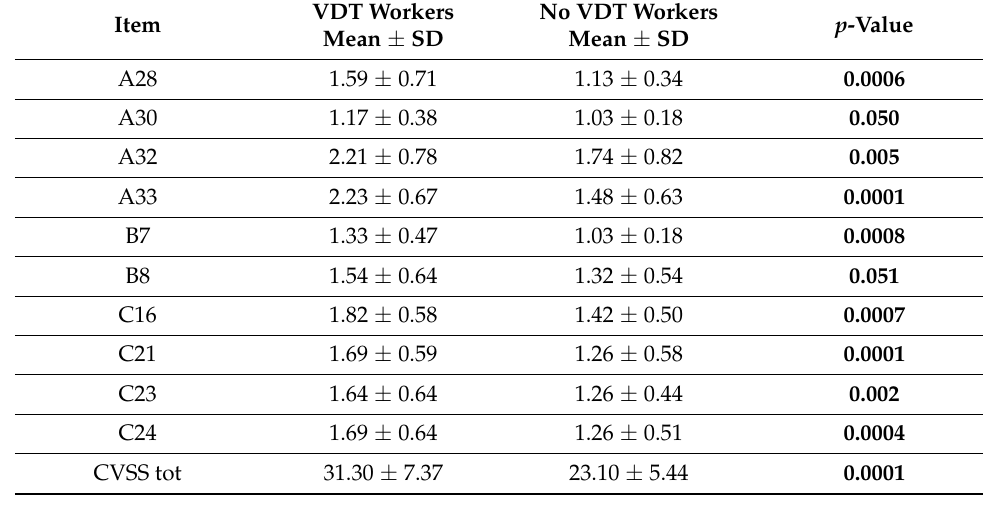
Table 2. Reliability: item-scale correlations and Cronbach’s alpha of the Italian version of the CVSS17 . Item Item-Test Correlation Table 3. Cont.